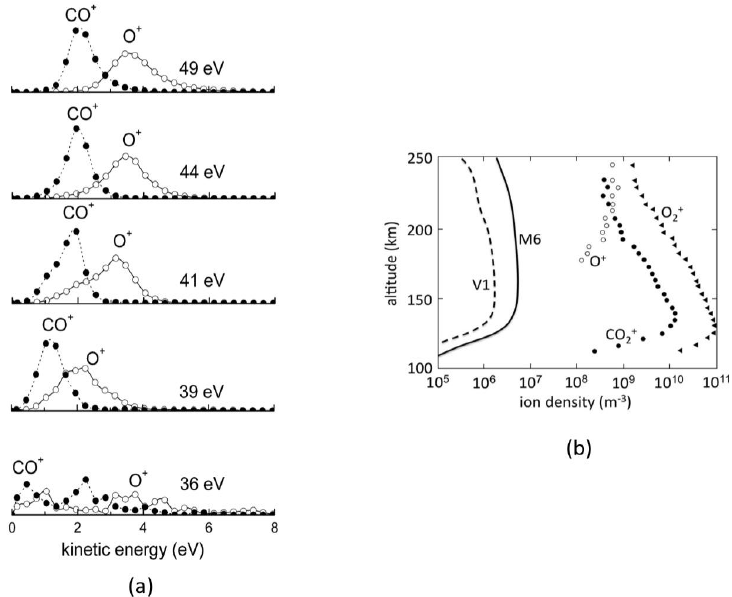
Figure 2. ( a ) Kinetic energy distributions for CO + and O + fragment ions originating by Coulomb explosion of CO 22+ dication produced in the double VUV photoionization experiment of CO 2 , as a function of the photon energy. ( b ) Calculation of CO 22+ ion density profiles for Viking 1 lander (V1) and Mariner 6 spacecraft (M6) conditions by Witasse et al. [33]. The O + , CO 2+ , and O 2+ densities profiles (on the right part of the panel) measured by Viking 1 lander are also plotted. Table 1. The range of measured values of KER distributions (eV) for fragments ions produced by VUV dissociative double photoionization of CO 2 , N 2 O, C 2 H 2 in the range of 28–65 eV compared with the typical escape energy (eV) for various ions in the atmosphere of Earth, Venus, Mars and Titan [28]. Typical Escape Energy (eV) for Various Ions in the Atmosphere Ionic Measured Range of KER (at the Exobase) of Some Planets of the Solar System [28] Species Distributions (eV) Earth Venus Mars Titan H + 2.8 ÷ 6.0 (a)